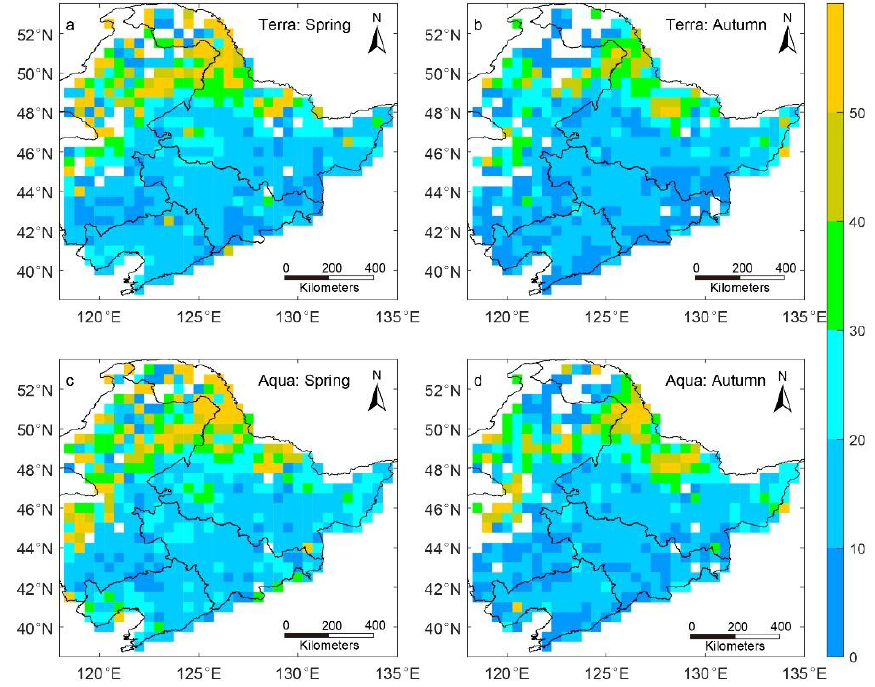
Figure 6. Spatial distribution of mean fire radiative power (unit: MW/spot) in different seasons of ( a , c ) spring and ( b , d ) autumn in northeastern China during 2003–2018 from ( a , b ) Terra and ( c , d ) Aqua fire products, respectively.